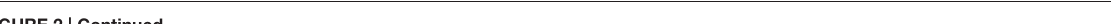
FIGURE 2 | Continued Phylogenetic relationships among coral-associated bacteria with described functions. Evolutionary history was inferred by using the Maximum Likelihood method based on the Kimura 2-parameter model (Kimura, 1980). The high number of bacteria that are shown with disease associations (coral pathogens, associated with BBD consortium, associated with coral diseases/syndromes) illustrates that much of the research describing coral-associated bacteria has been focussed